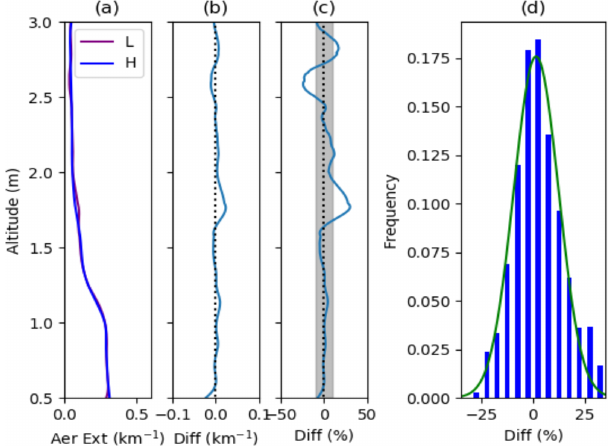
Figure 6. Comparison of the LMOL- and HALO-derived 292nm aerosol extinction coefficient at 13:17EDT on the afternoon of 28 August 2018 using the S 1 and AE values selected in Sect. 3.2. The HALO aerosol extinction profile is converted from the 532nm aerosol extinction product. Panel (a) shows the LMOL and HALO aerosol extinction; panel (b) displays the difference between the LMOL and HALO aerosol extinction; panel (c) gives the percent- age difference between the LMOL and HALO aerosol extinction; and panel (d) shows the error (percentage difference) probability distribution function for all available comparisons between 0.5 and 2.5km for August 2018. In panel (d) , the width between each bar shows 5%